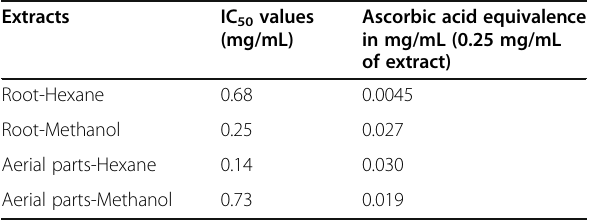
Table 5 IC 50 and ascorbic acid equivalence of the extracts of V . coriaceum in hydroxyl radical